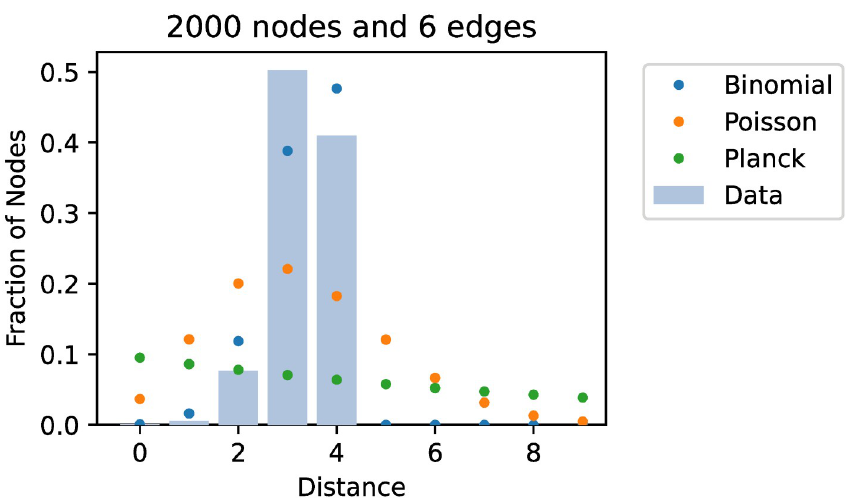
Fig 4. Fitted discrete distributions from an example dataset, which was created using 2000 nodes and 6 edges per node. Only the binomial estimation using the ceiling operator to discretize the parameters shows any resemblace to the desired